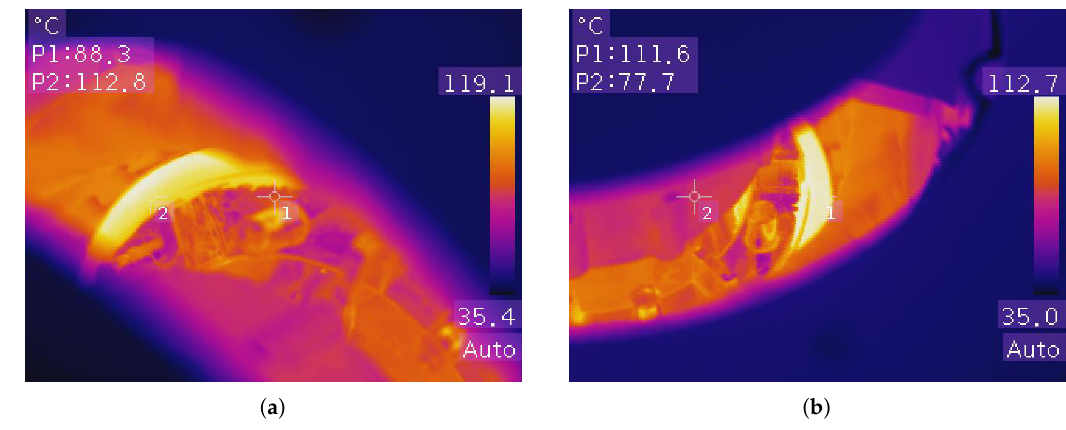
Figure 16. Thermal pictures acquired with thermal camera THT 70 (frame rate 50 Hz) of reference SPM rotor taken with thermal camera: ( a ) thermocouples on stator winding; ( b ) thermocouples on permanent-magnets. The number of thermocouples is consistent with Figure